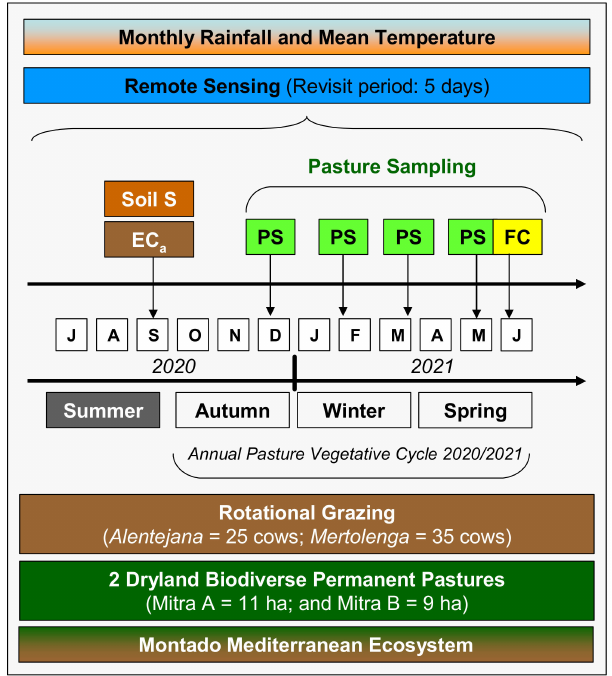
Figure 1. Diagram of the experimental approach proposed procedure. PS, pasture sampling; FC, floristic composition; Soil S, soil sampling; EC a , soil apparent electrical